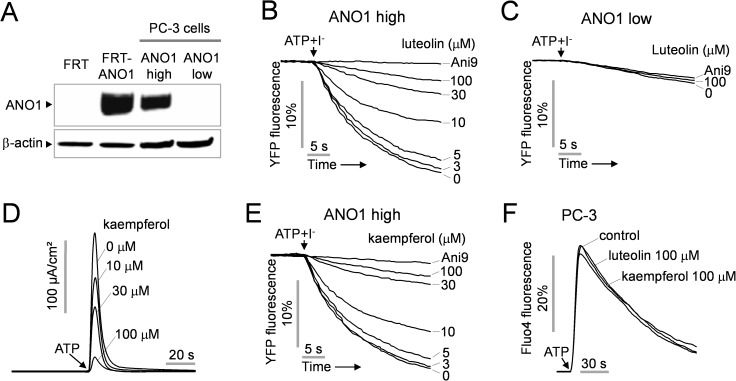
Effect of luteolin and kaempferol on the ANO1 activity of PC-3 cells.A) Immunoblot of ANO1 protein in FRT, FRT-ANO1 and PC-3 cells expressing high and low levels of ANO1. Representatives of three sets of studies are shown. B, C) ANO1 activity was measured in PC-3 cells expressing high and low levels of ANO1. ANO1 activity was inhibited by the indicated concentrations of luteolin and Ani9 (1 μM), a specific ANO1 inhibitor. D) Effect of kaempferol on ANO1 channel activity was observed in FRT-ANO1 cells. Indicated concentration of kaempferol was pretreated for 20 min and then 100 μM ATP was applied to activate ANO1. E) Effect of kaempferol on ANO1 activity in PC-3 cells expressing high levels of ANO1. F) Effect of luteolin and kaempferol on calcium signaling was measured using Fluo-4 in PC-3 cells.